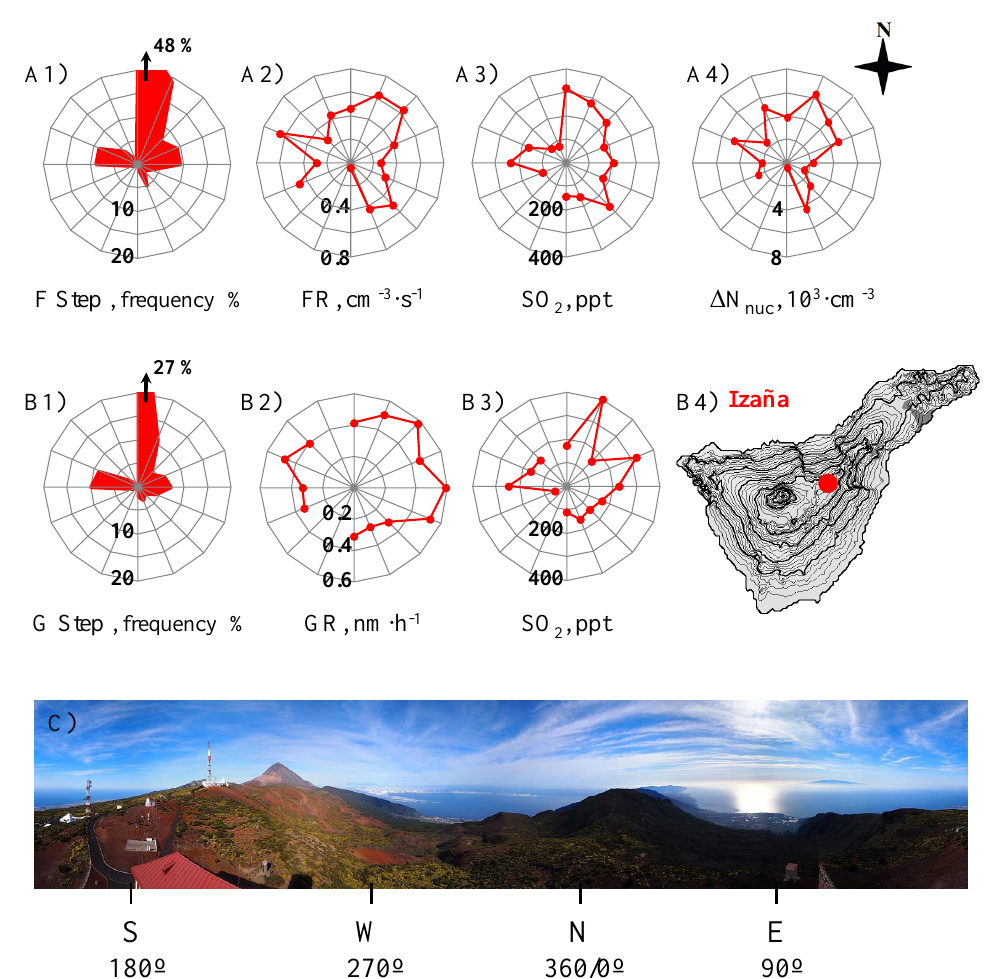
Fig. 8. Wind rose for formation step parameters ( (A) frequency, formation rates, SO 2 and nucleation particles concentration) and for growth step parameters ( (B) frequency, growth rates and SO 2 concentration). (B4) Topographic map of Tenerife. (C) 360 ◦ view from Izaña obser-